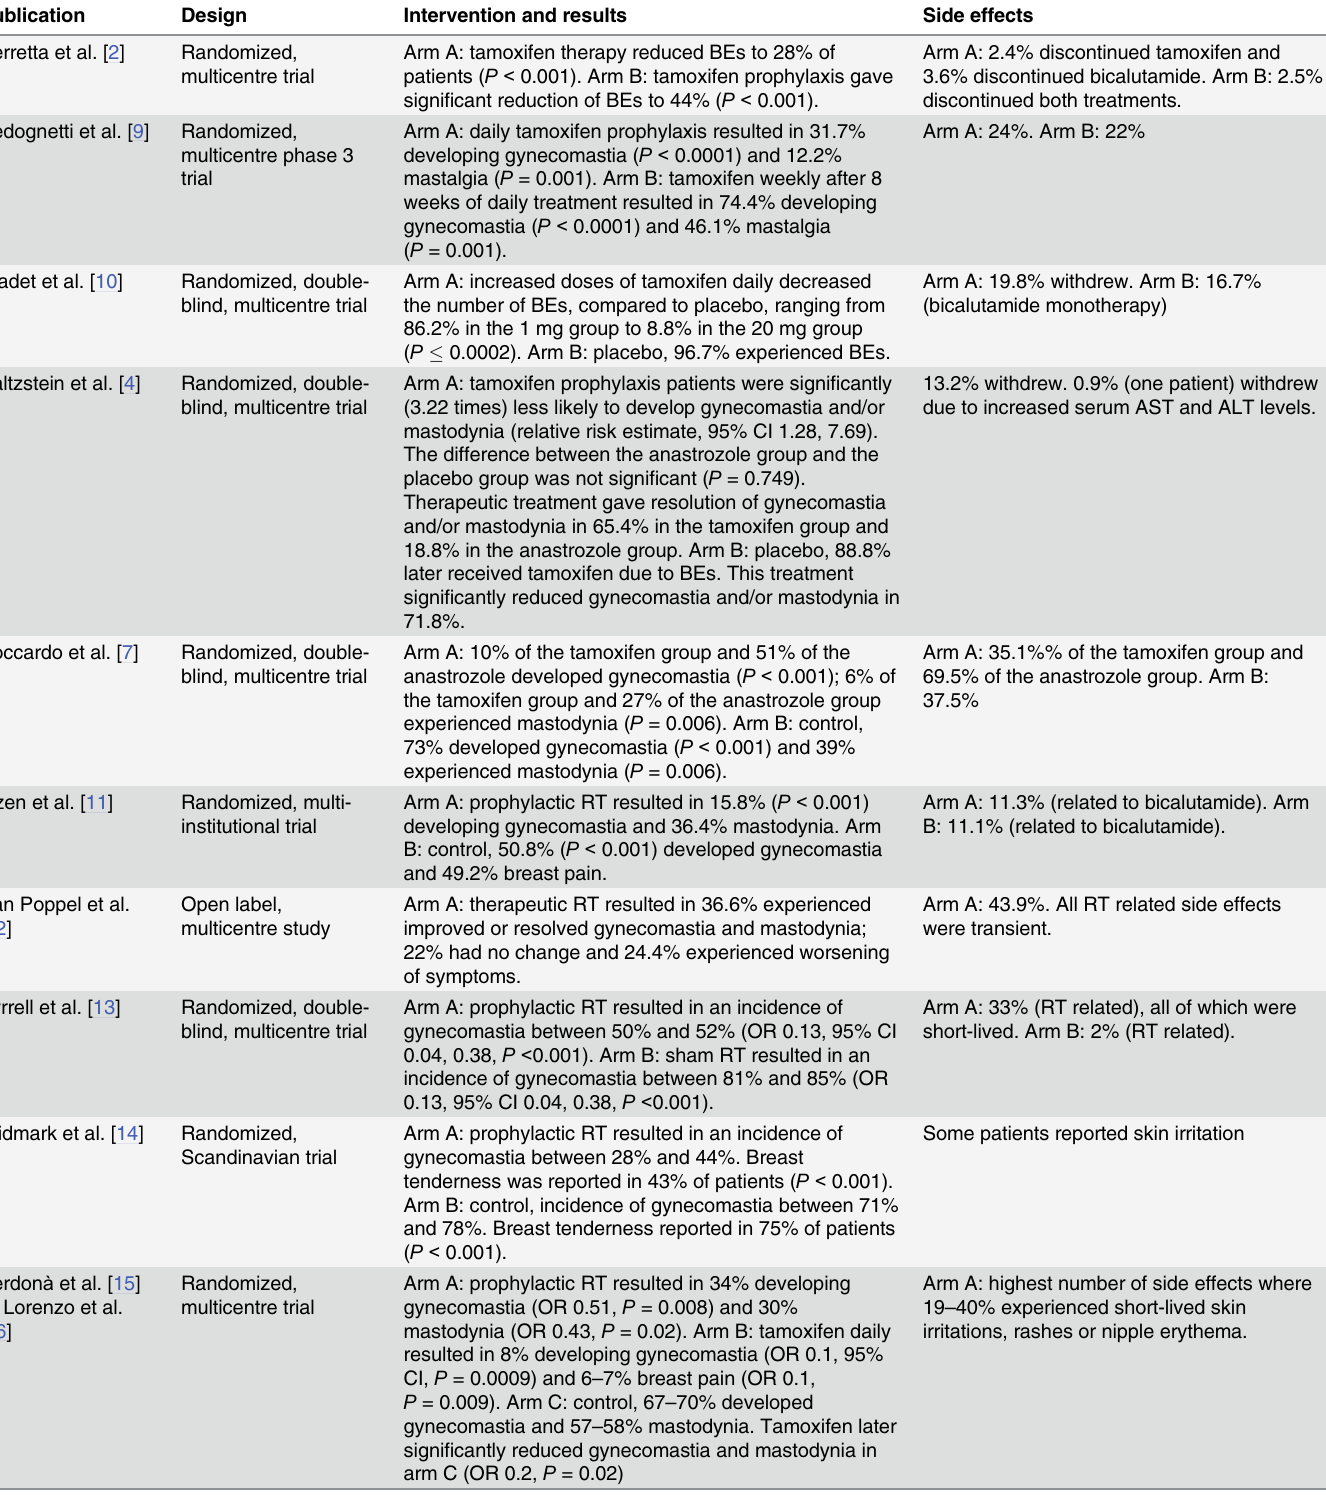
Table 4. Primary